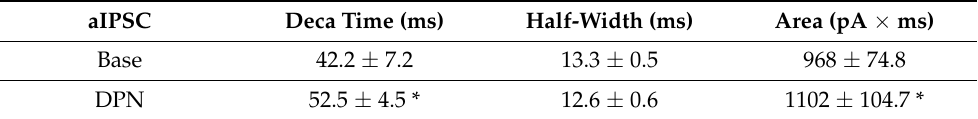
Figure 4. Activation of ERß on inhibitory transmission in the PFC of female mice. ( a , c ) No significant changes were found in the average sIPSC amplitude and sEPSC frequency recordings in the mPFC during baseline and after E2 treatment. ( b , d ) Within-cell analyses show that activation of ERß led to opposing reactions on sIPSC amplitude and frequency in a subset of cells. ( e , f ) The proportion of cells with a significant response to DPN treatment. ( g ) Sample traces, frequencies and amplitudes of sEPSCs before and after DPN treatment. ( h ) No correlations were found between changes in sIPSC frequency and sIPSC amplitude. Table 1. Kinetics of spontan GABAergic currents in Base and after application of DPN in